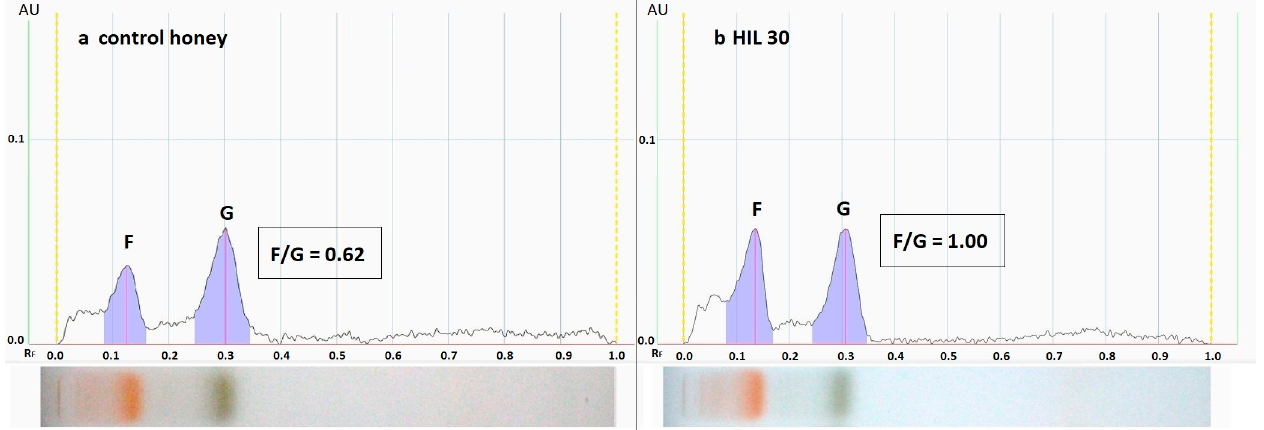
Figure 2. Exemplary of sugar HPTLC chromatograms and generated profiles: ( a )—control honey, ( b )—HIL 30, peaks: F—fructose, G—glucose.